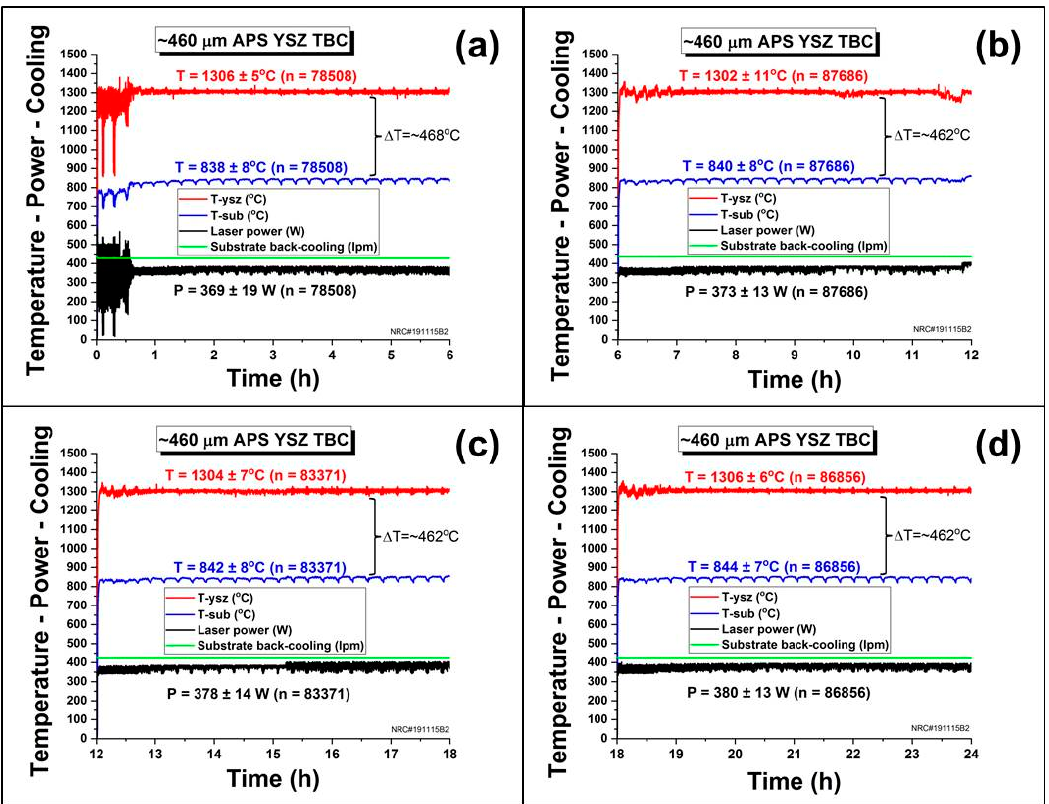
Figure 9. Laser-rig thermal gradient results for the ~460-µm-thick porous APS YSZ TBC: ( a ) 0–6 h; ( b ) 6–12 h; ( c ) 12–18 h; ( d ) 18–24 h.